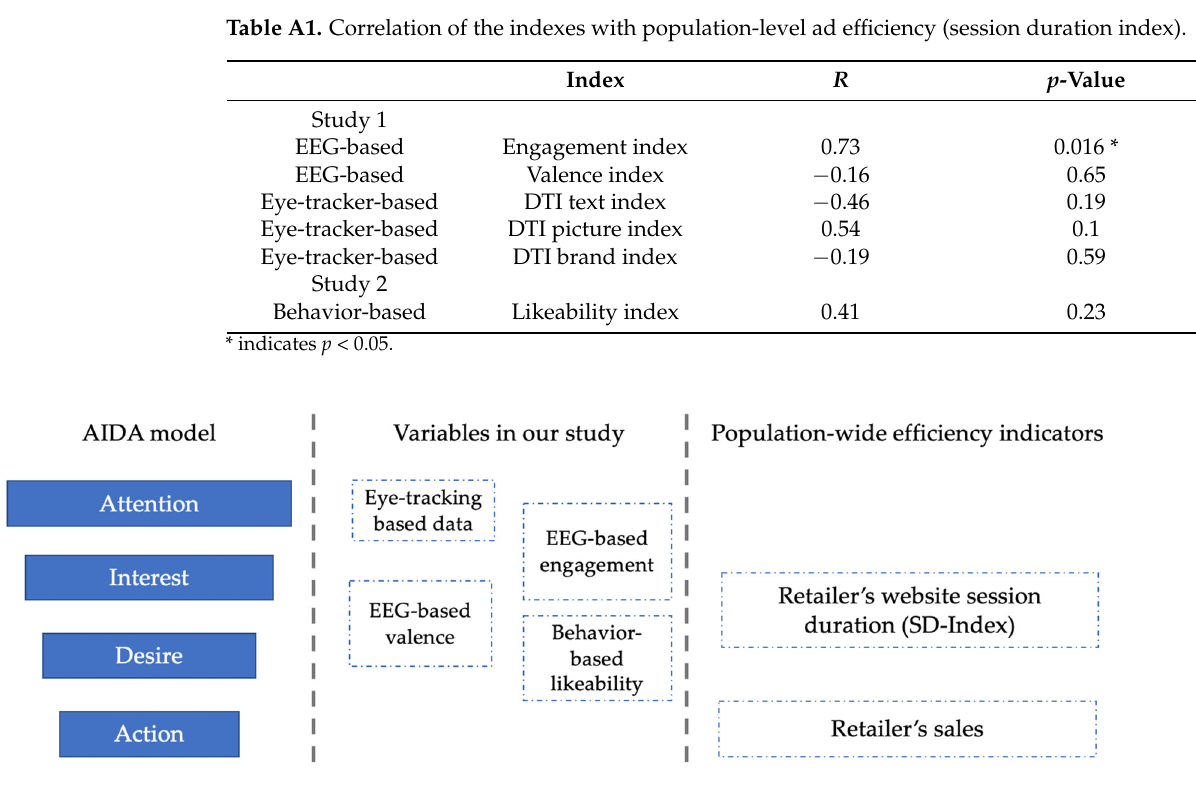
Figure A1. Theoretical framework of the study design.